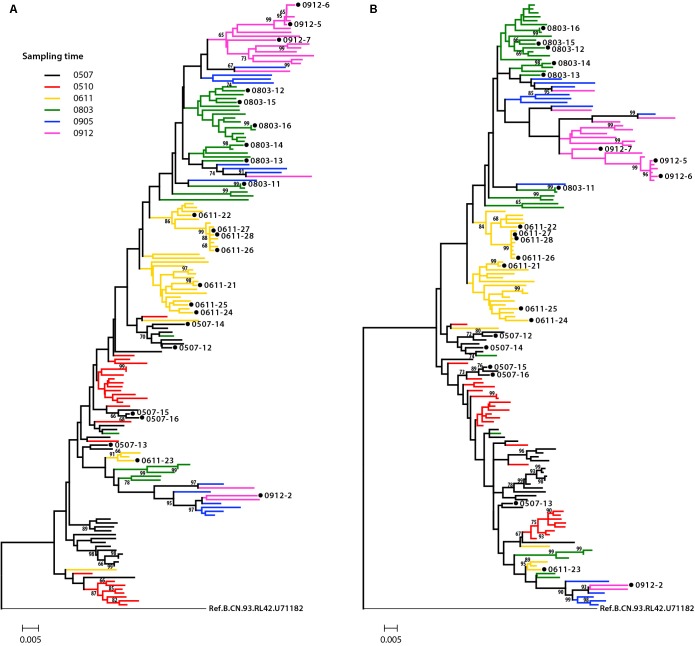
Phylogenetic tree of HIV-1 envelope sequences. A total of 155 gp160 sequences from an HIV-1-infected donor DRVI01 were aligned with the reference sequence B.CN.RL42.U71182. The tree was constructed based on sequence distance and rooted at B.CN.RL42.U71182 for visualization. (A) The protein phylogenetic tree was built by the Neighbor-Joining method with the Jones–Taylor–Thornton model. (B) The nucleotide phylogenetic tree was reconstructed by the maximum-likelihood method with GTR+Γ4+I substitution model. The tree showed that a main viral population and a minor viral population have evolved in parallel in the patient for more than 4.5 years, and the latter is not eliminated over time. The gp160 sequences were color coded as follows: black, June 2005; red, October 2005; yellow, 2006; green, 2008; blue, May 2009; purple, December 2009. The horizontal branch scale is indicated for each tree.